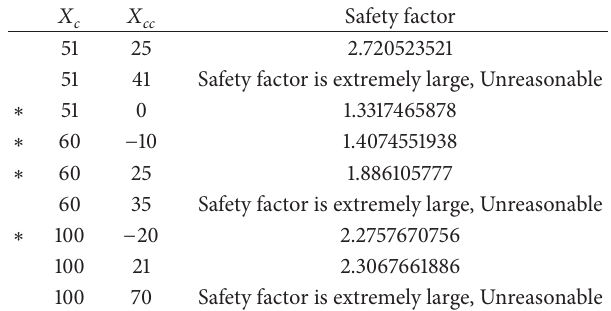
Table 1: A population of randomly generated individuals.